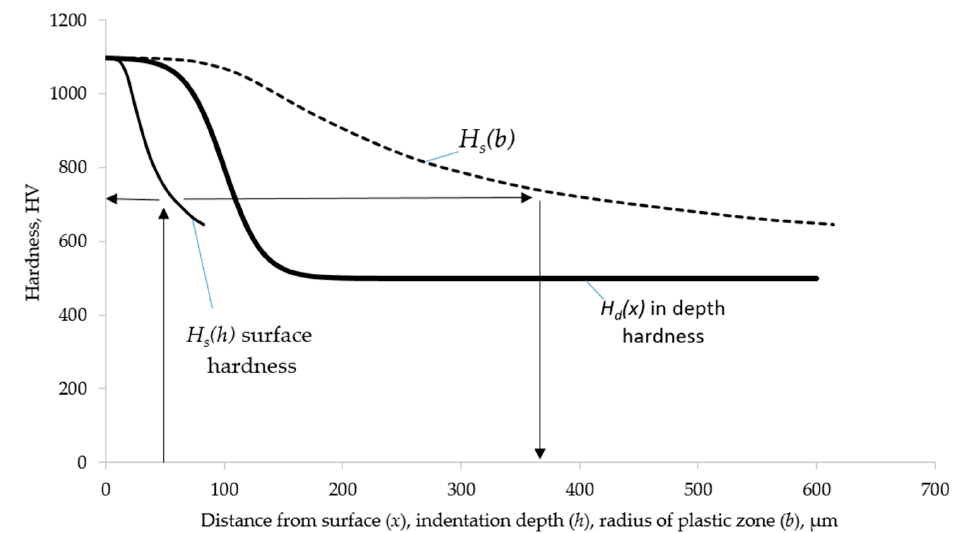
Figure 6. In-depth and surface hardness function and the radius of the plastic